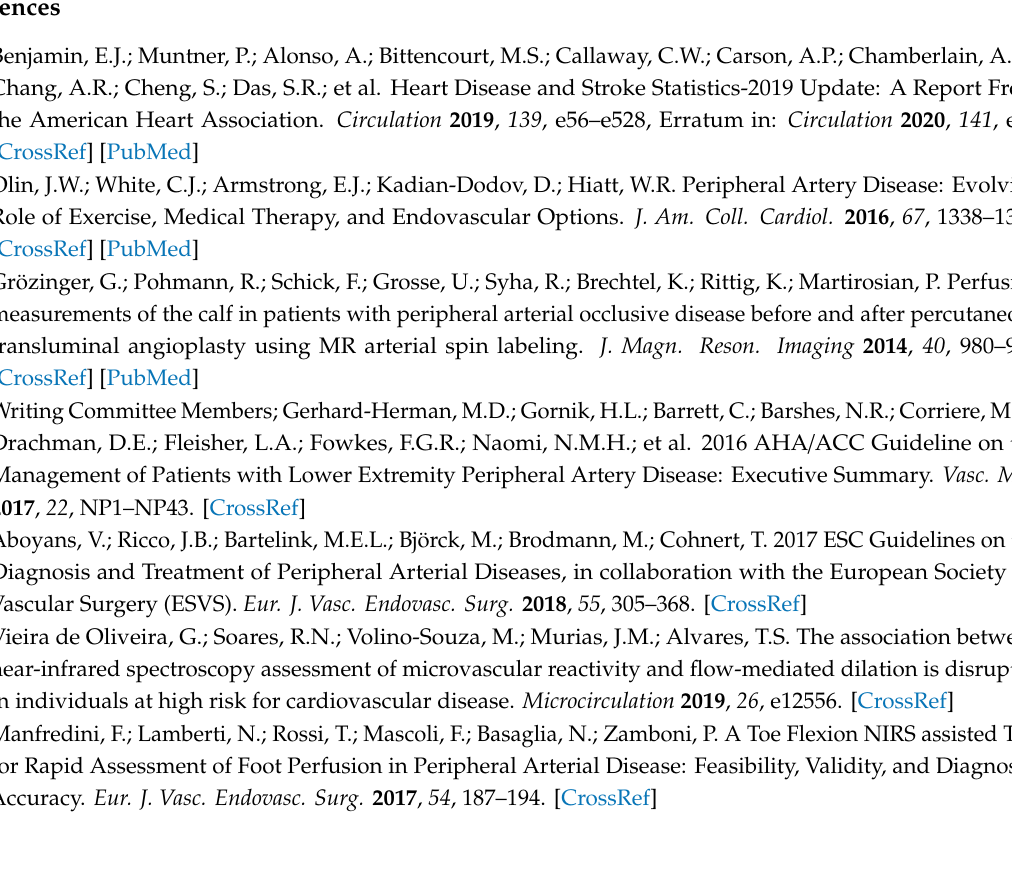
Figure S1: Representation of oxygenated hemoglobin trace and MMb-oxy (colored area) at baseline (a) and after interventions (b) in one patient for each